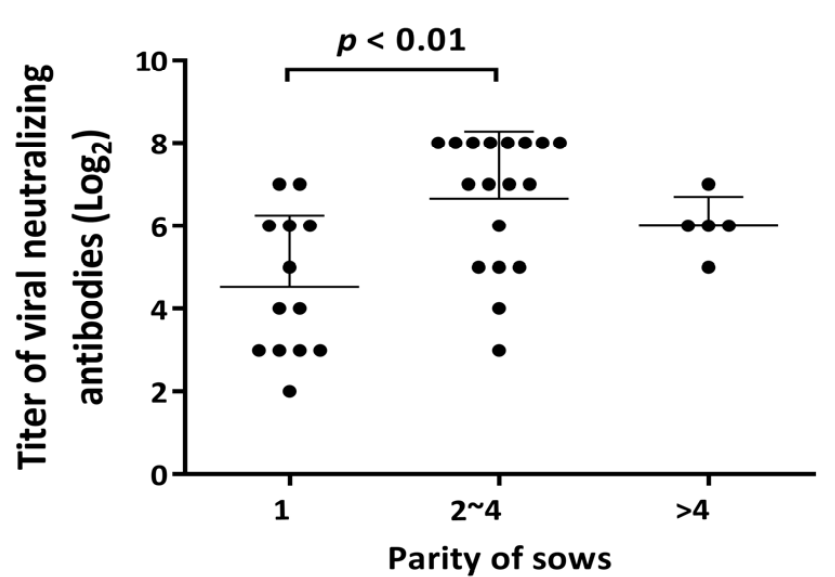
Figure 2. Detection of viral neutralizing antibodies in all sows. Data are displayed as the average NAbs titers, with error bars representing the standard deviations. The black dots represent each raw NAbs titer from the sows. Titers of neutralizing antibodies (NAbs) were as follows: 4.54 ± 1.65 log 2 in first parity, 6.67 ± 1.56 log 2 in second to fourth parities and 6.00 ± 0.63 log 2 in over fourth parties. Significant differences in NAbs titers were observed between the first and second to fourth parities ( p < 0.01).